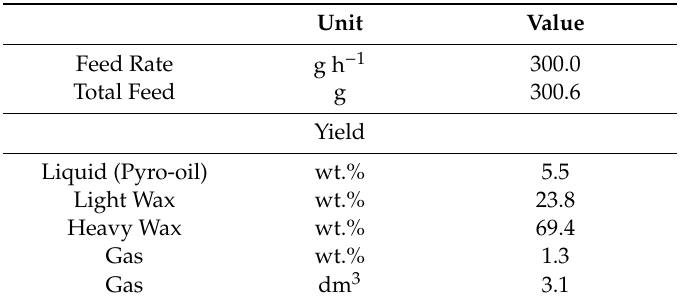
Table 1. Overall Process Mass Balance in The Reactor